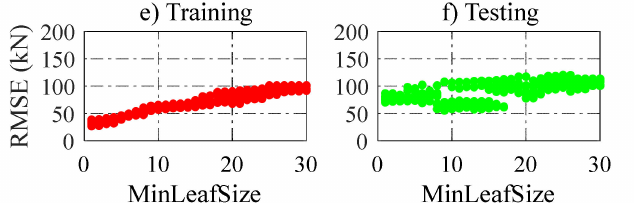
Figure 5. The performance of 210 DT models.